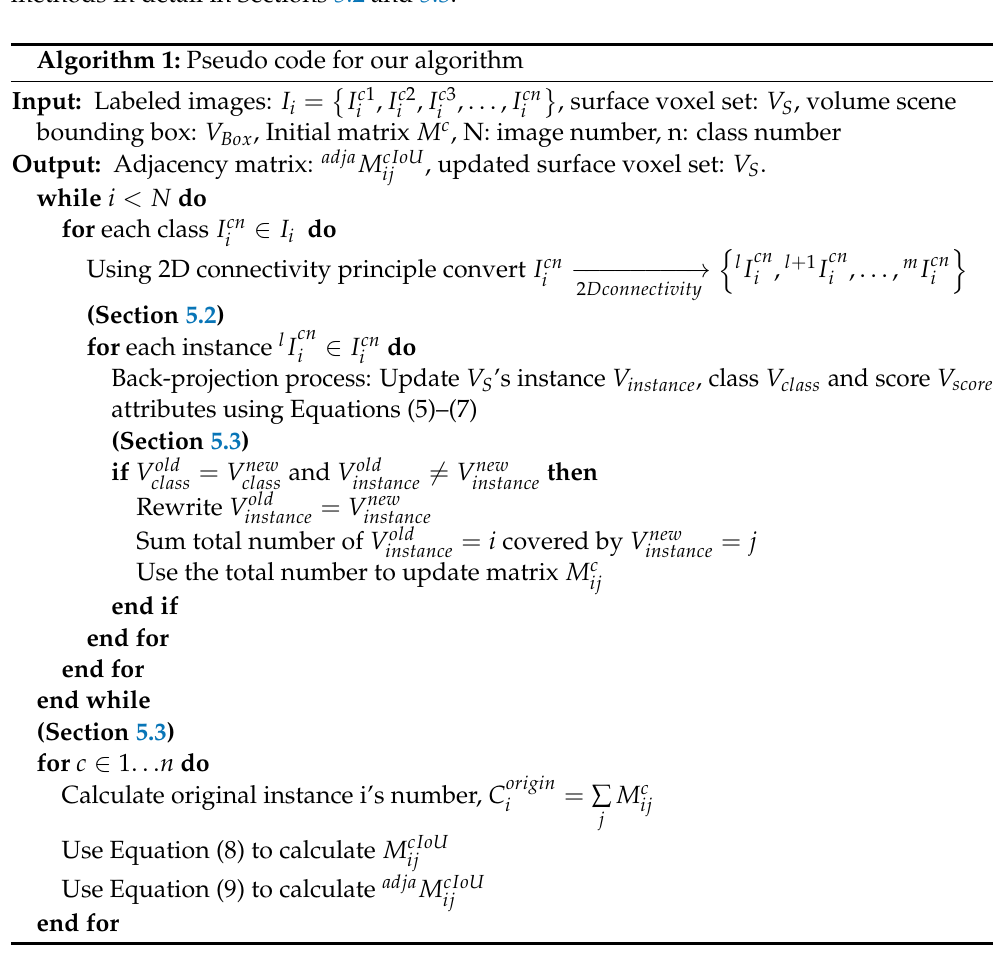
Algorithm 1: Pseudo code for our